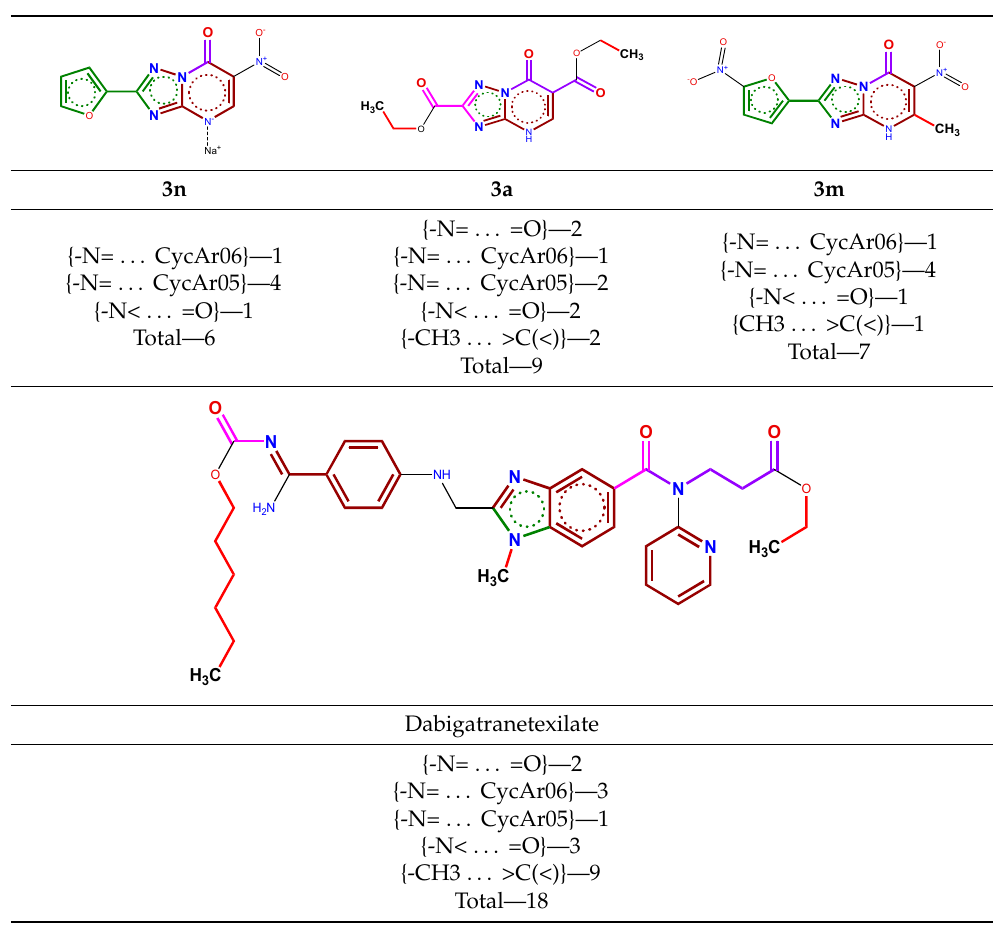
Figure 2. Pharmacophore that defines a high level of FIIa-inhibitory activity of novel compounds . Incorporation of the constructed pharmacophore into the structures of the three most active compounds and dabigatran etexilate is shown in Table 3. Table 3. Entry of the identified pharmacophore into structures of the most active FIIa inhibitors and dabigatran etexilate.